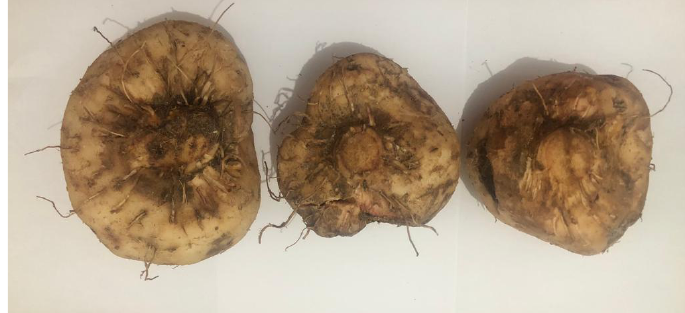
Figure 7. Tuber of Tacca leontopetaloides